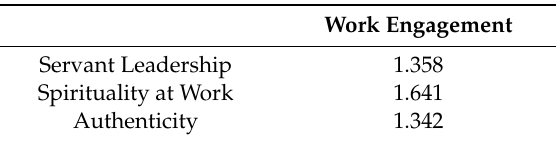
Table 2. Full collinearity